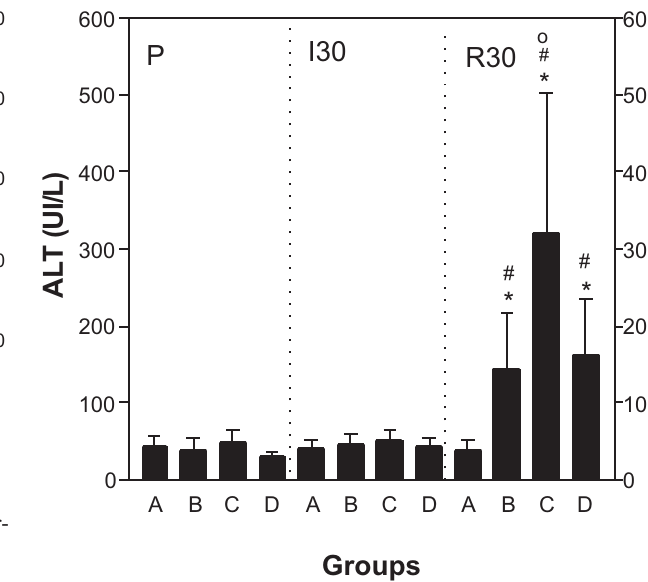
FIGURE 2 – Serum alanine transferase (ALT) level in animals during the surgical procedure The columns represent the mean and the vertical bars indicate the standard de- viation.